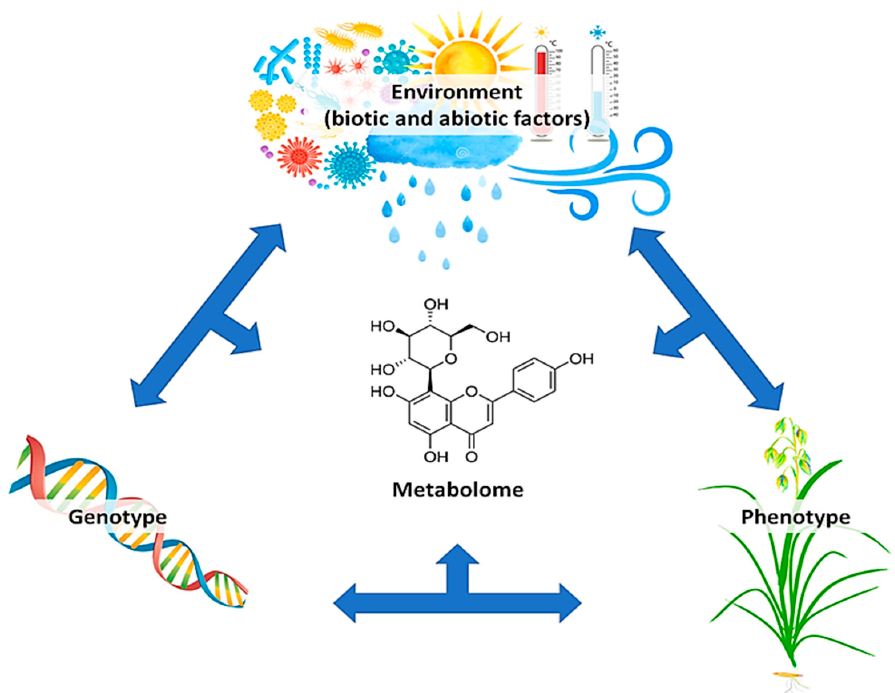
Figure 1. Triangular arrangement illustrating the genotype × environment × phenotype interactions, with the metabolome at the core, bridging the gap between the genotype and phenotype. The metabolome is the final recipient of biological information flow and carries imprints of genetic and environmental factors. It is more sensitive to perturbations in both metabolic fluxes and enzyme activity than either the transcriptome or proteome and is thus a reflection of the phenotype. Quantitative, global measurements of the metabolome therefore provide an exploration of cellular metabolism, revealing patterns and functional signatures of the biochemical landscape and cellular physiology of the system under consideration [8–10].